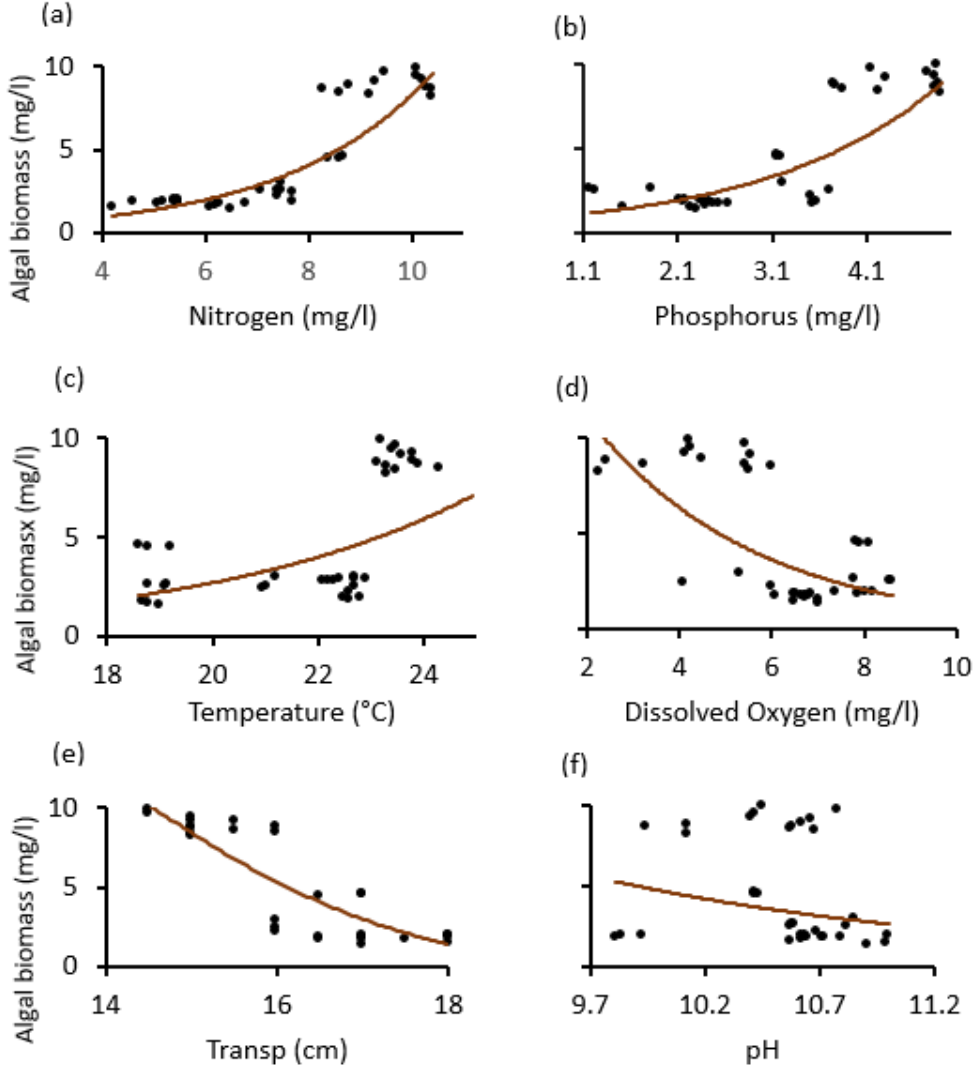
Figure 6. Relationship changes between algal biomass and the physico–chemical variables; ( a ) Nitrogen, ( b ) Phosphorus, ( c ) Temperature, ( d ) dissolved oxygen, ( e ) Transp. (water transparency) and ( f ) pH, during the study period from May 2020 to April 2021 at Lake Big Momella, Tanzania.